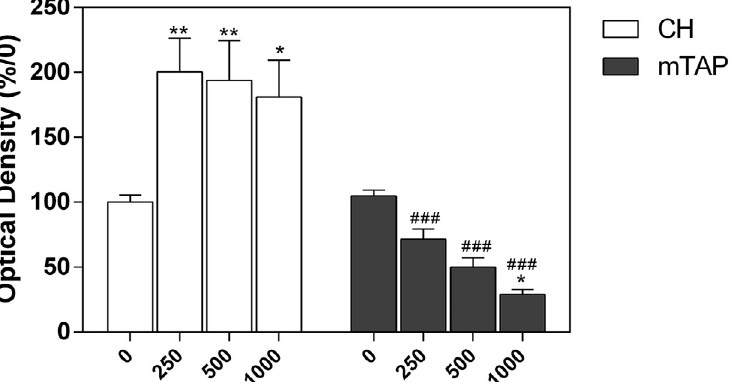
Figure 2- CH and mTAP cytotoxicity on APCs at the indicated concentrations for 5 days. Cell viability detected by MTT assay and normalized based on control (untreated) cells. *P<.05 and ***P<.001 in comparison to culture medium alone (0) (n=9